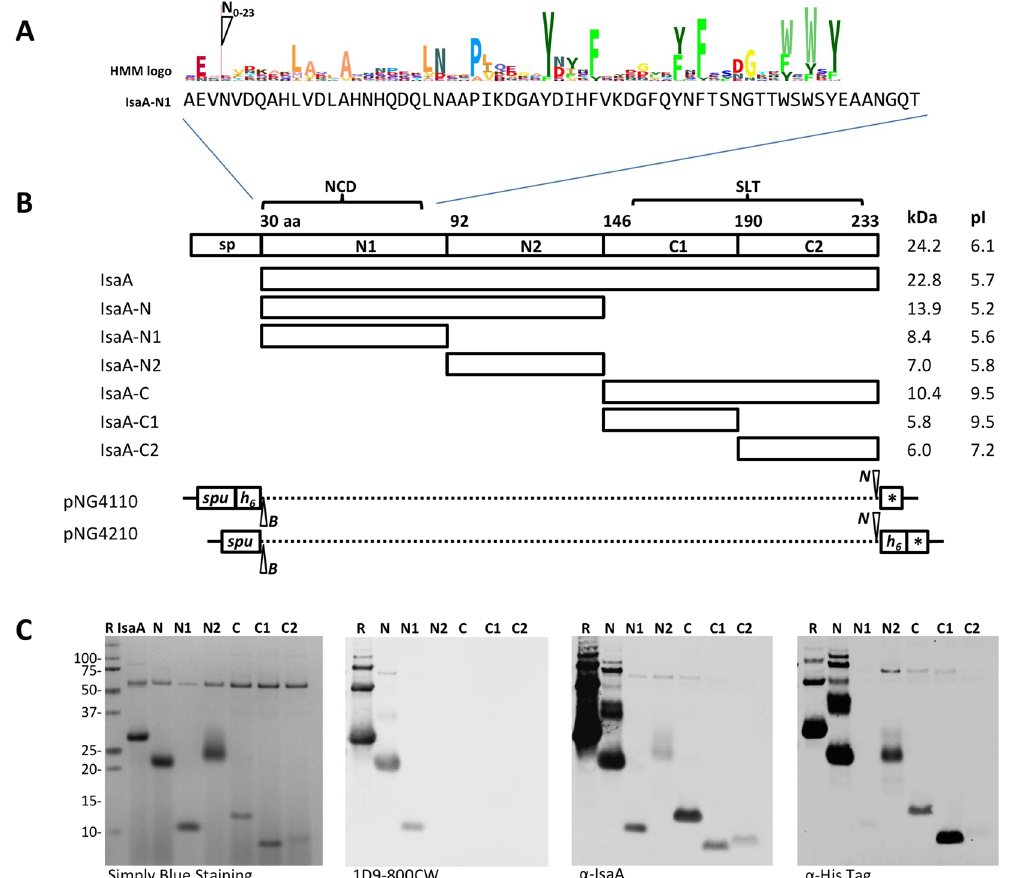
Figure 1. Schematic representation of IsaA subdomains, their separate expression and immunodetection. ( A ) The N-terminal conserved domain (NCD) of IsaA (residues 30–84) as identified by BLASTP searches with the N-terminal region of IsaA (residues 30–145; see also Supplementary Fig. 1). ( B ) The mature IsaA, its N-terminal (IsaA-N, IsaA-N1, IsaA-N2) or C-terminal (IsaA-C, IsaA-C1, IsaA-C2) fragments were expressed in L . lactis PA1001 and secreted as N-terminal or C-terminal His-tag fusions using the lactococcal signal peptide of Usp45 ( spu ). The C-terminal part of IsaA contains a soluble lytic transglycosylase (SLT) domain (pfam01464). In the schematic representations of the expression vectors pNG4110 and pNG4210, used to produce IsaA or its subdomains, the positions of the cleavage sites for the restriction enzymes Bam HI ( B ) and Not I ( N ), and the N-terminal or C-terminal His-tags ( h 6 ) are indicated. Molecular weights (kDa) of IsaA and its subdomains and their isoelectric points (pI) are indicated. sp, IsaA signal peptide; * Stop codon provided within the expression vectors pNG4110 and pNG4210. ( C ) LDS-PAGE analysis of growth medium fractions of nisin-induced L . lactis cultures producing the C-terminally His-tagged IsaA protein or IsaA fragments. The His-tagged proteins are visualized either by Simply Blue gel-staining, or by Western blotting with the humAb 1D9–800CW, the polyclonal α -IsaA rabbit antibodies, or α -His-tag antibodies. Molecular weights (kDa) of the standard proteins are indicated on the